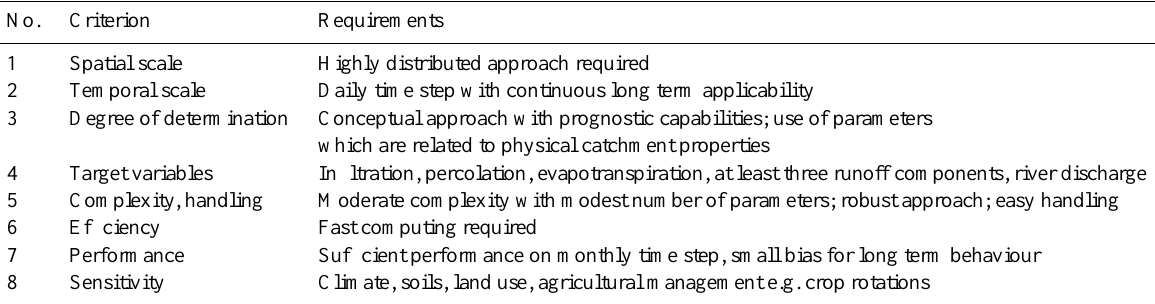
Table 1. Requirements on hydrological models to be used as part of decision support